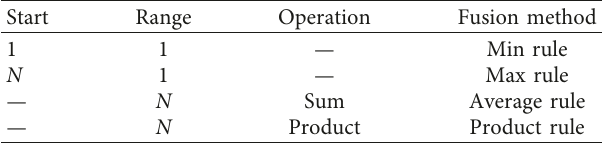
Table 1: Special cases of the sliding window fusion method. Start